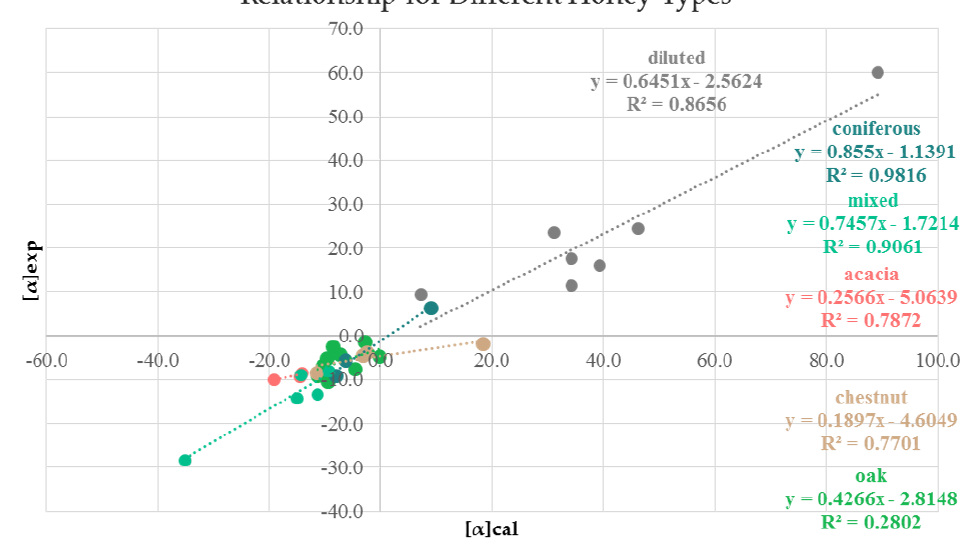
Figure 5. Linear relationship between experimentally determined [α]exp and calculated [α]cal op- tical rotation angle for different honey